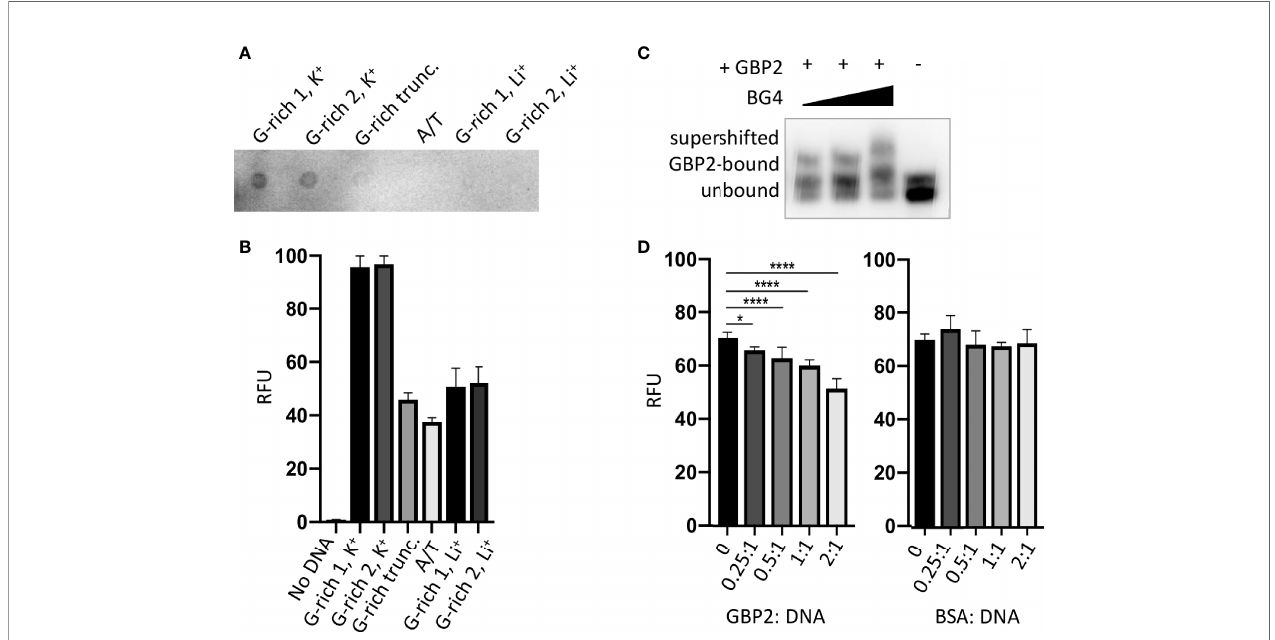
FIGURE 4 | Pf GBP2 binds to G4-folded DNA. (A) Dot-blot of the indicated oligonucleotides ( Table S2 ) probed with the G4-speci fi c antibody BG4. Image is representative of triplicate experiments. (B) Fluorescence emission from the indicated oligonucleotides in the presence of the G4-speci fi c dye thio fl avin T (ThT). Error bars represent SD from technical triplicates. (C) EMSA assay as in Figure 3B , with BG4 antibody added to the DNA/ Pf GBP2 complex at 0.5:1, 1:1 and 2:1 molar ratio of antibody to puri fi ed Pf GBP2. (D) Fluorescence emission from G-rich oligonucleotide 1 bound to thio fl avin T, as in (B) , with the addition of increasing quantities of puri fi ed Pf GBP2 or the control protein BSA. Protein : DNA molar ratios between 0.25:1 and 2:1 were tested. *P<0.05,